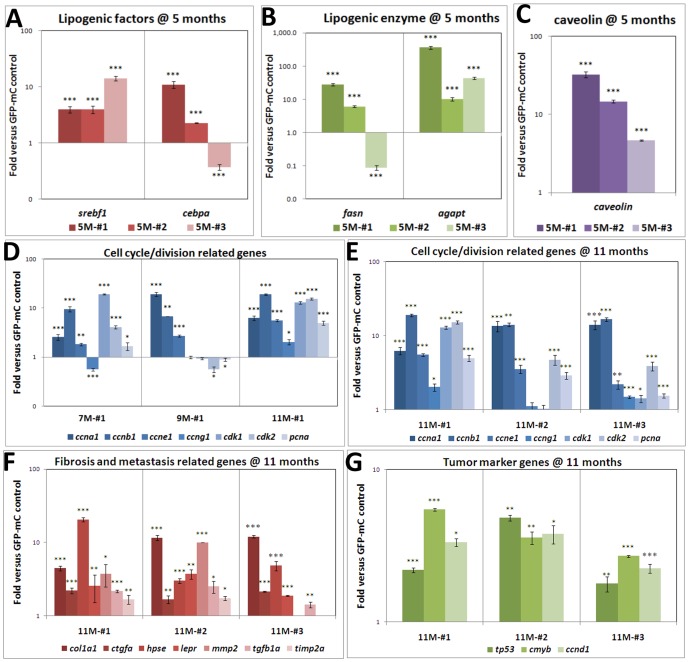
Quantitative RT-PCR analysis of selected marker genes in edn1 transgenic fish.Genes encoding (A) lipogenic factors, (B) lipogenic enzymes, and (C) PPAR-gamma were up-regulated in 5-month-old edn1 transgenic fish. (D) Cell cycle/division-related genes were analyzed in fish aged 7 to 11 months and were found to be up-regulated most significantly at 11 months. (E) Cell cycle/division-related genes from three independent edn1 transgenic fish at 11 month of age were compared. (F) Fibrosis- and metastasis-related genes and (G) tumor markers were up-regulated at 11 months. The mRNA levels of these genes in the liver samples of three independent edn1 transgenic fish and the age matched GFP-mCherry control fish were analyzed by qPCR at 5 different ages (3, 5, 7, 9, and 11 months). Each Ct value was normalized using β-actin as control, and was then compared with the Ct value determined for the GFP-mCherry control fish, and then were converted into fold differences. The formula for the relative quantification is: ΔΔCt  =  (Ct,target −Ct,β-actin)edn1 fish−(Ct,target −Ct, β-actin)GFP-mC fish, and fold change  = 1.94−ΔΔCt. Multiple replicates were performed, and the means are presented with their standard deviations. The differences among the variables were assessed using a two-tailed Student's t-test. Significant differences between the control and edn1 transgenic fish are indicated (*, P<0.05; **, P<0.01; and ***, P<0.001).